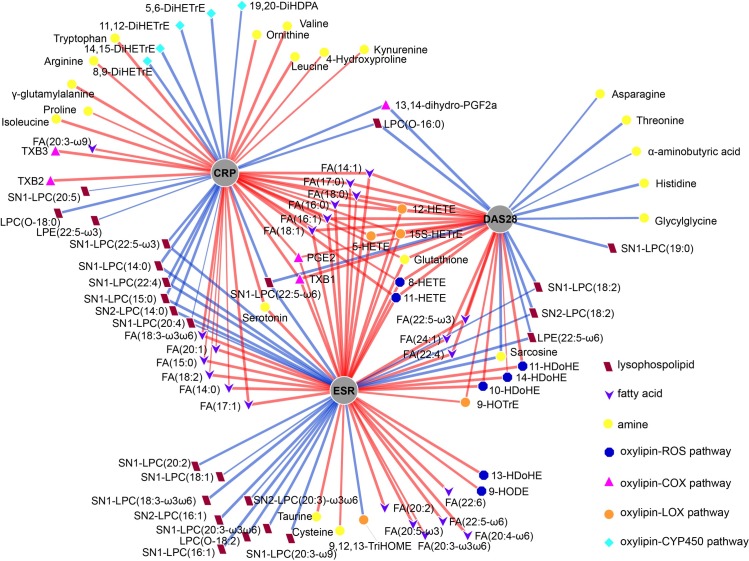
Visualization of the associations between metabolites and disease activity − general inflammation (log-transformed CRP and ESR) and RA-specific inflammation (DAS28)–based on the complete cohort of bDMARD users (n = 231).The metabolites that associated with either CRP, ESR or DAS based on linear generalized estimating equations (GEE), were grouped according to metabolic classes (LPCs, FAs, amines and oxylipins), which are represented as color-coded symbols adjacent to the metabolites. The metabolites in these metabolic classes showed comparable associations with CRP, ESR and/or DAS28. FAs positively- and the lysophospholipids negatively associated with CRP, ESR and/or DAS28; the association between other the oxylipins and amines with CRP, ESR and/or DAS28 were mixed, based on their metabolic functions. Positive associations are indicated with red lines, negative associations with blue lines; thicker lines indicate a more significant association. CRP, C-reactive protein; DAS28, disease activity score based on 28 joint counts; ESR: erythrocyte sedimentation rate; FA, fatty acid; LPE, lysophosphatidylethanolamine; LPC, lysophosphatidylcholine